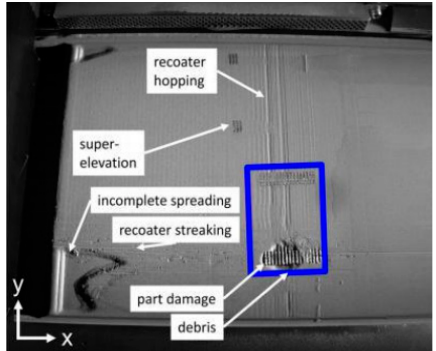
Figure 8. Anomaly diagram of powder bed [35].